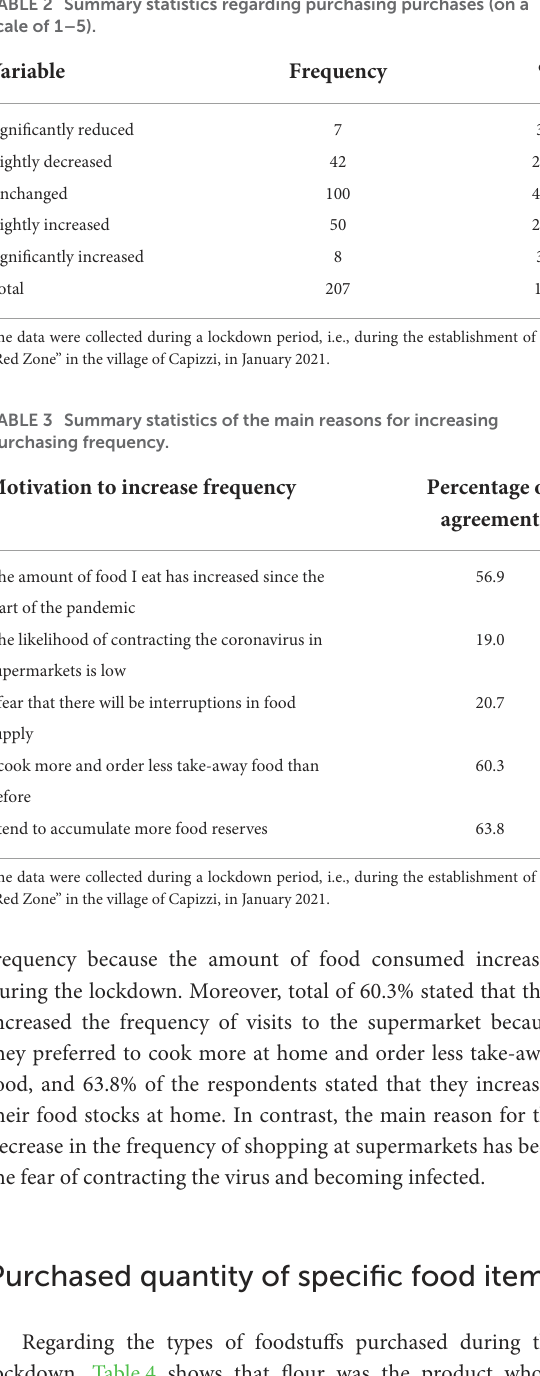
TABLE 4 Summary of changes in the quantity of specific foodstuffs.